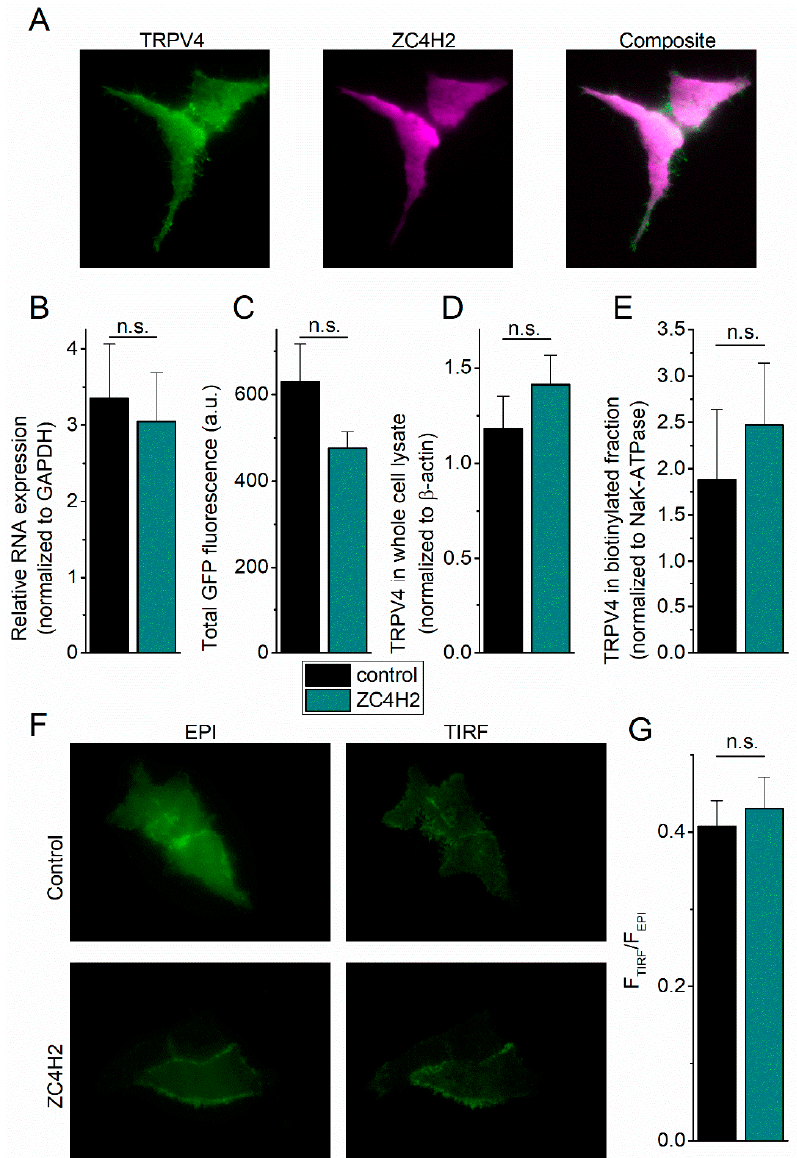
Figure 3. ZC4H2 does not affect the expression or subcellular localization of TRPV4. ( A ) Representative TIRF images showing the localization of heterologously expressed TRPV4-GFP and ZC4H2-mCherry. ( B ) Relative mRNA expression of TRPV4 in cells co-transfected with ZC4H2 or mCherry control. Data are normalized to the housekeeping gene Glyceraldehyde-3-Phosphate Dehydrogenase (GAPDH). ( n = 11) ( C ) Mean TRPV4-GFP fluorescence (EPImode). ( n = 245 for ZC4H2, 220 for control) ( D ) Mean TRPV4 expression in whole cell lysate after SDS-PAGE. ( n = 14) ( E ) Mean TRPV4 expression in the biotinylated fraction, normalized to the NaK-ATPase (plasma membrane marker). ( n = 8) ( F ) Representative images showing TRPV4 GFP fluorescence measured in epifluorescence (EPI) mode and TIRF mode in cells co-transfected with ZC4H2 or mCherry control. ( G ) Ratio of TRPV4-GFP fluorescence in TIRF mode versus EPI mode, as an estimate of the distribution of TRPV4-GFP between the bulk cell and the perimembrane area in close vicinity of the coverslip. ( n = 24 for ZC4H2, n = 21 control). Values are mean ±